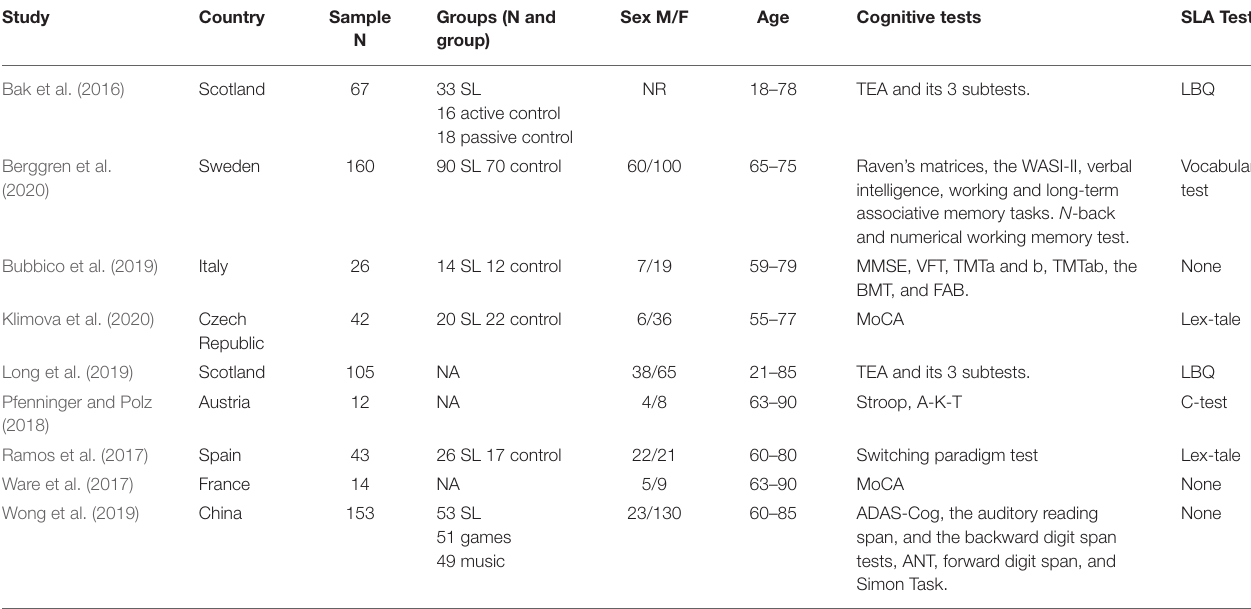
TABLE 2 | Summary of participants and